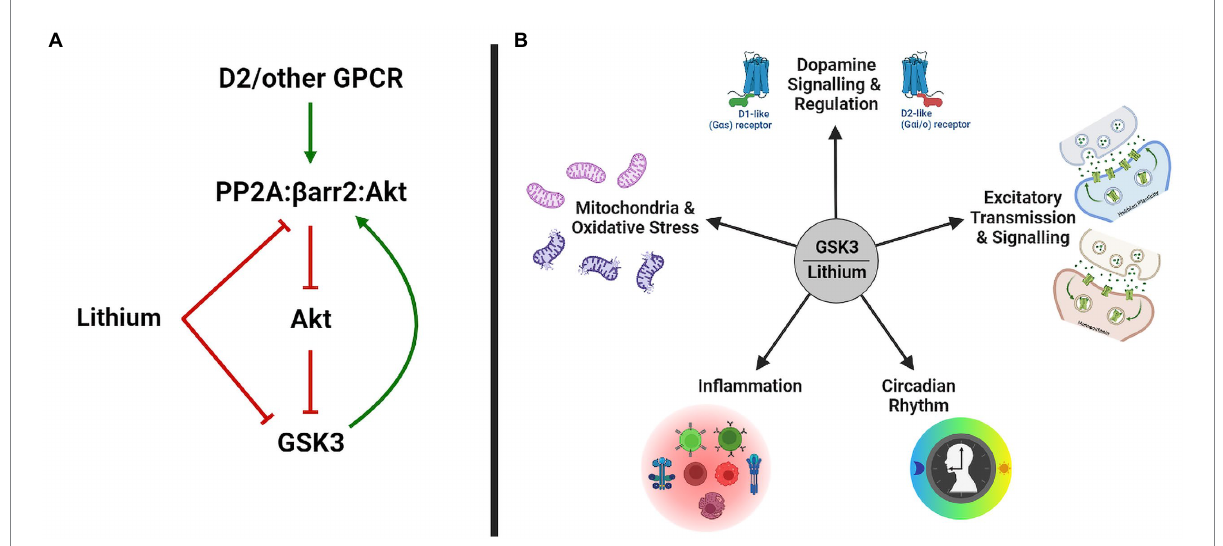
FIGURE 1 GSK3 and Lithium. (A) Lithium inhibits GSK3 directly and indirectly, by disrupting the PP2A/ β arr2/Akt complex and increasing Akt activity. (B) Biological functions modulated by GSK3 and lithium in bipolar disorder. GSK3, glycogen synthase kinase-3; GPCR, g-protein coupled receptor; and PP2A, protein phosphatase